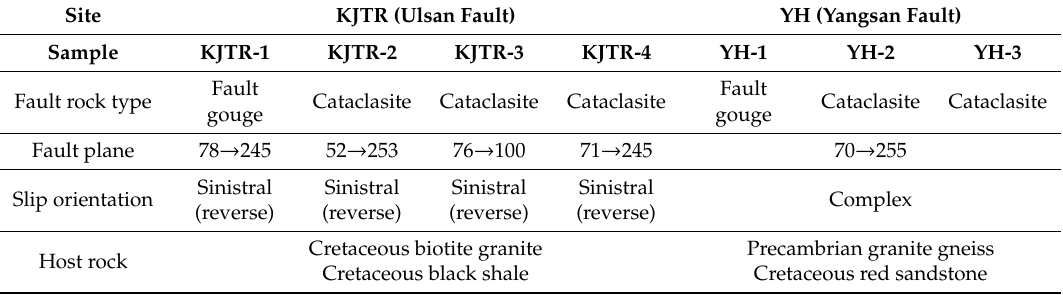
Table 1. Information about the outcrops from which each sample was obtained. The types of fault rock and host rock, orientation of the fault plane, and orientation of the fault slip inferred from field observations are